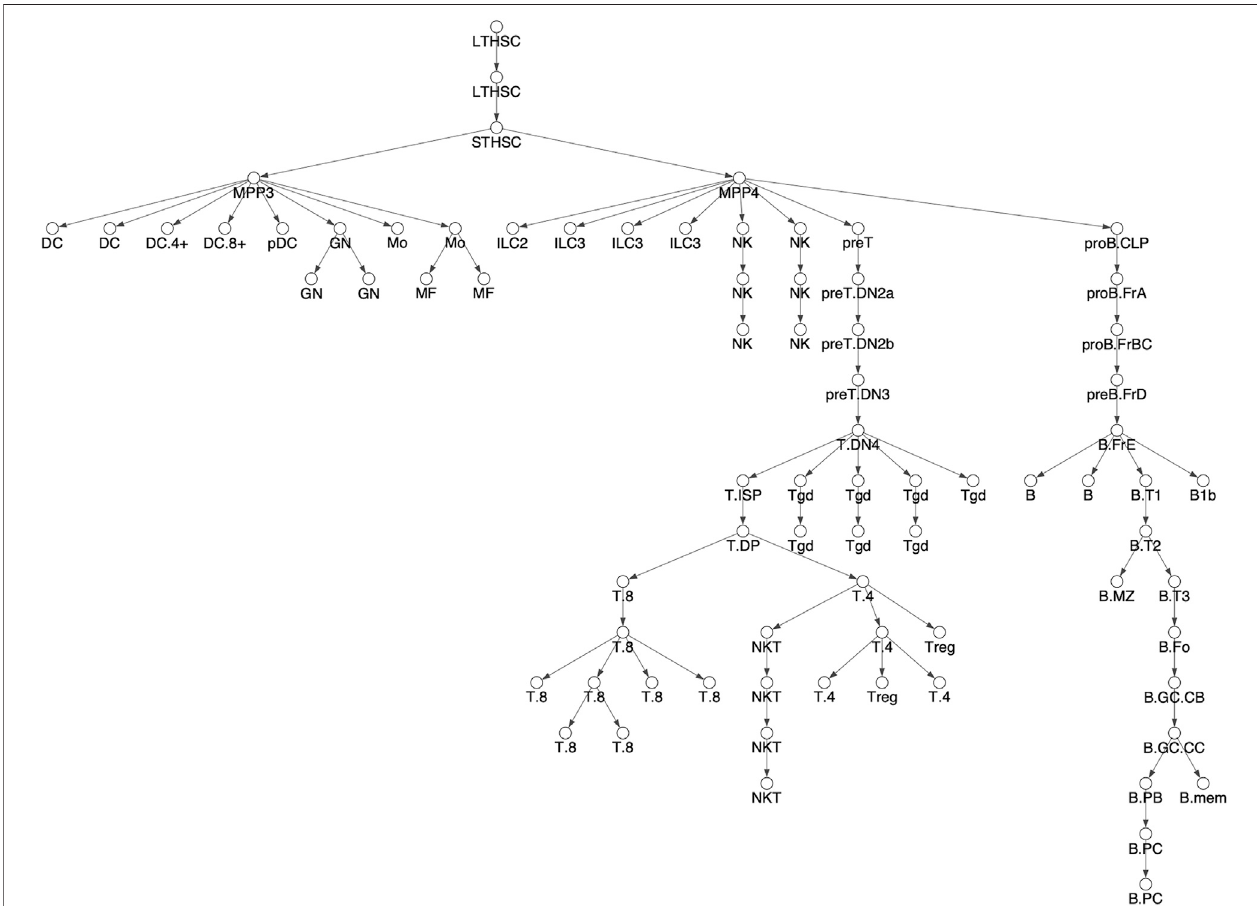
FIGURE 2 | Differentiation tree. We considered 78 hematopoietic cell types and assumed the shown tree structure. The tree structure is the same as Figure 3A in Yoshida et al. Cell types names have been shortened for readability, see Supplementary Figure S1 for full names corresponding to Yoshida et al.